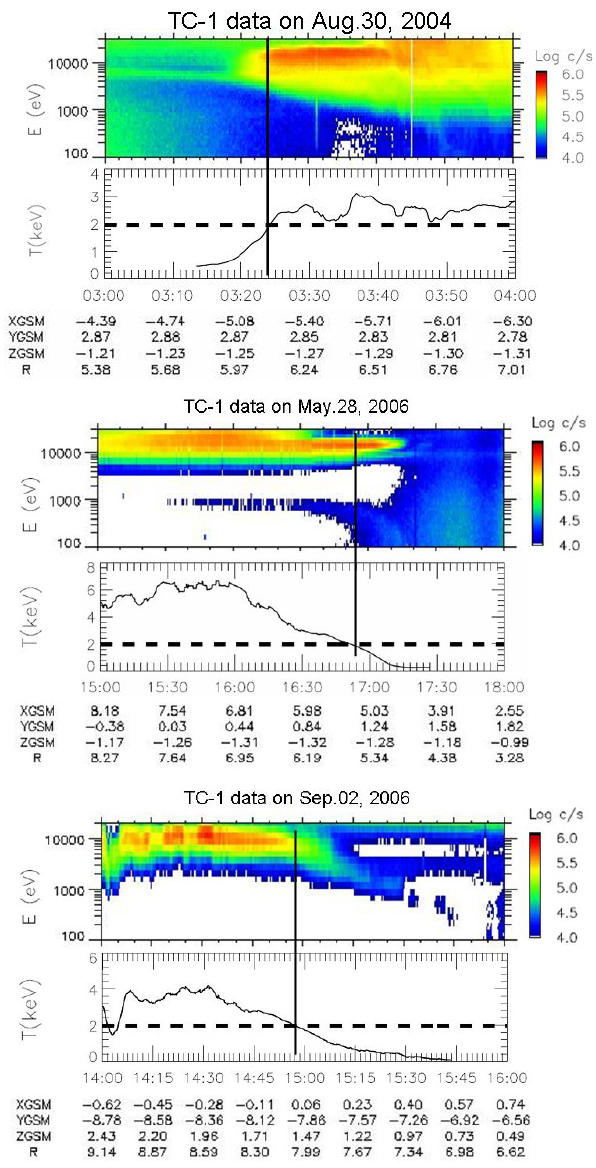
Fig. 1. The ion energy spectrum and ion temperature during three IBIPS crossing events.